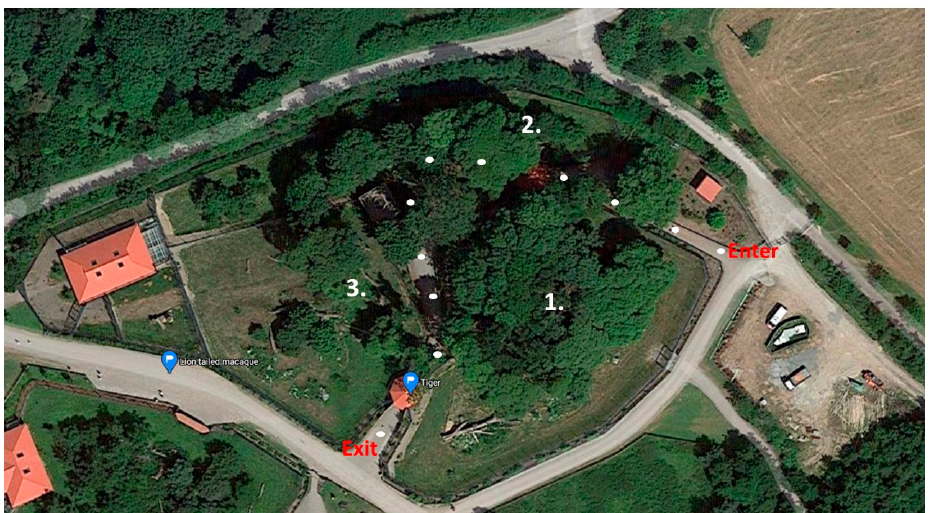
Figure 1. Sumatran tiger habitat at Fota Wildlife Park with visitor walkway marked with entry and exit points in red and a trail of white dots to show the approximate route through the exhibit. The three tiger enclosures included in the study marked 1, 2 and 3 in white.